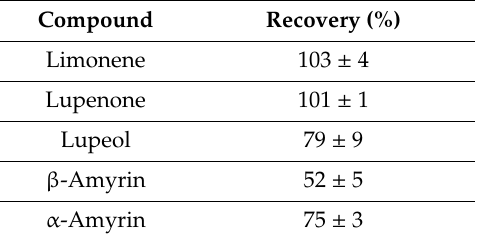
Table 2. Recoveries * obtained from the spiked extracts ( n = 3).